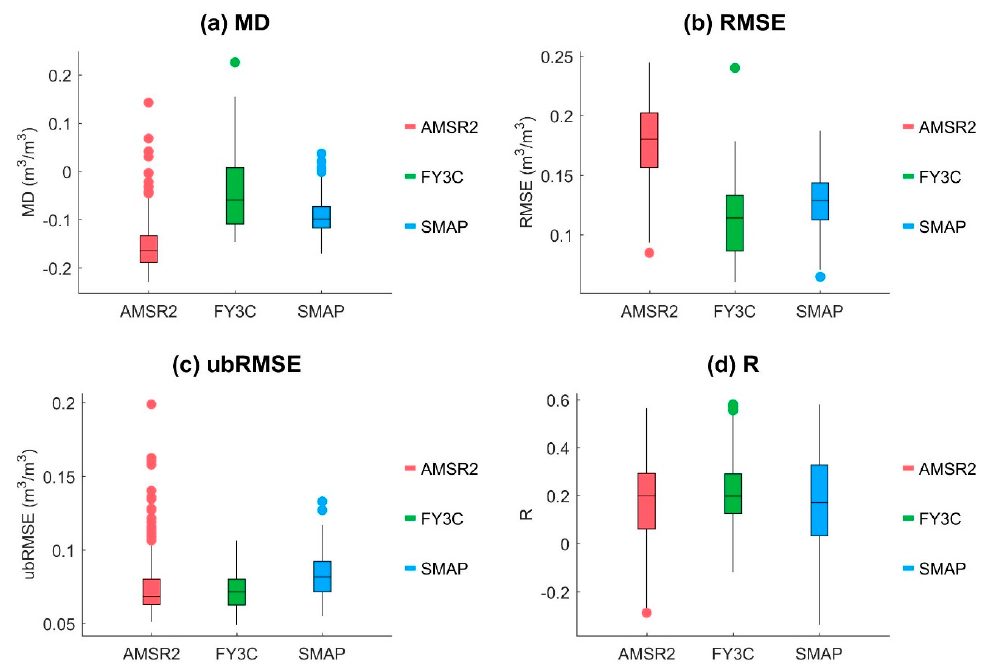
Figure 9. The spatial statistical indices of the FY-3C, AMSR2, and SMAP soil moisture datasets against the in-situ measurements for all of the valid dates during the year: ( a ) MD, ( b ) RMSE, ( c ) ubRMSE, and ( d ) R. The number of valid days of FY3C, AMSR2, and SMAP used for statistics was 233, 366, and 295,